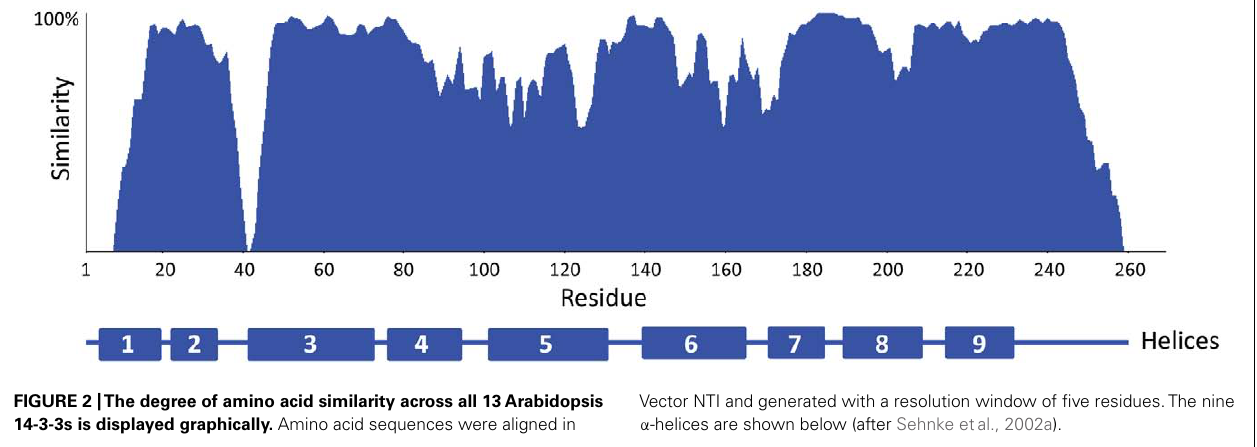
FIGURE 2 |The degree of amino acid similarity across all 13Arabidopsis 14-3-3s is displayed graphically. Amino acid sequences were aligned in